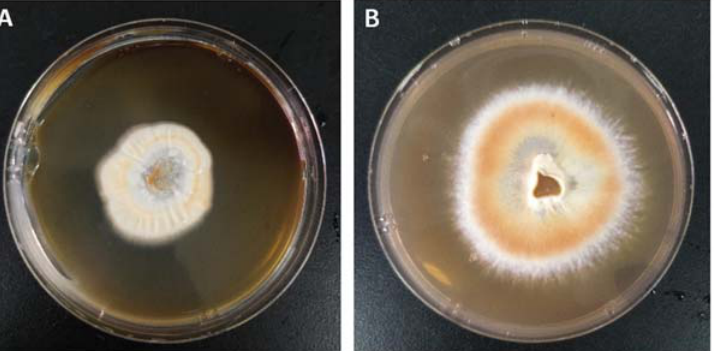
Figure 3. A. camphorata mycelia were cultured in solid media at different temperatures: ( A ) cultured at 30 °C and ( B ) cultured at 25 °C.